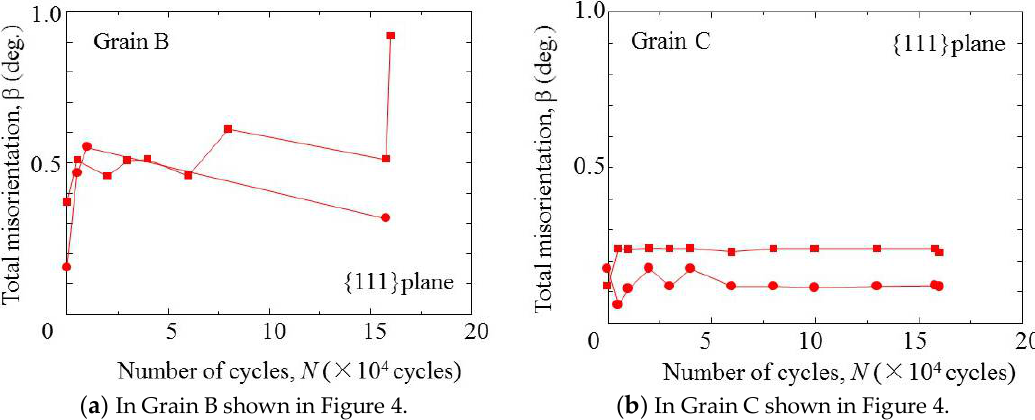
Figure 5. Change of total misorientation of individual grain in fatigue.